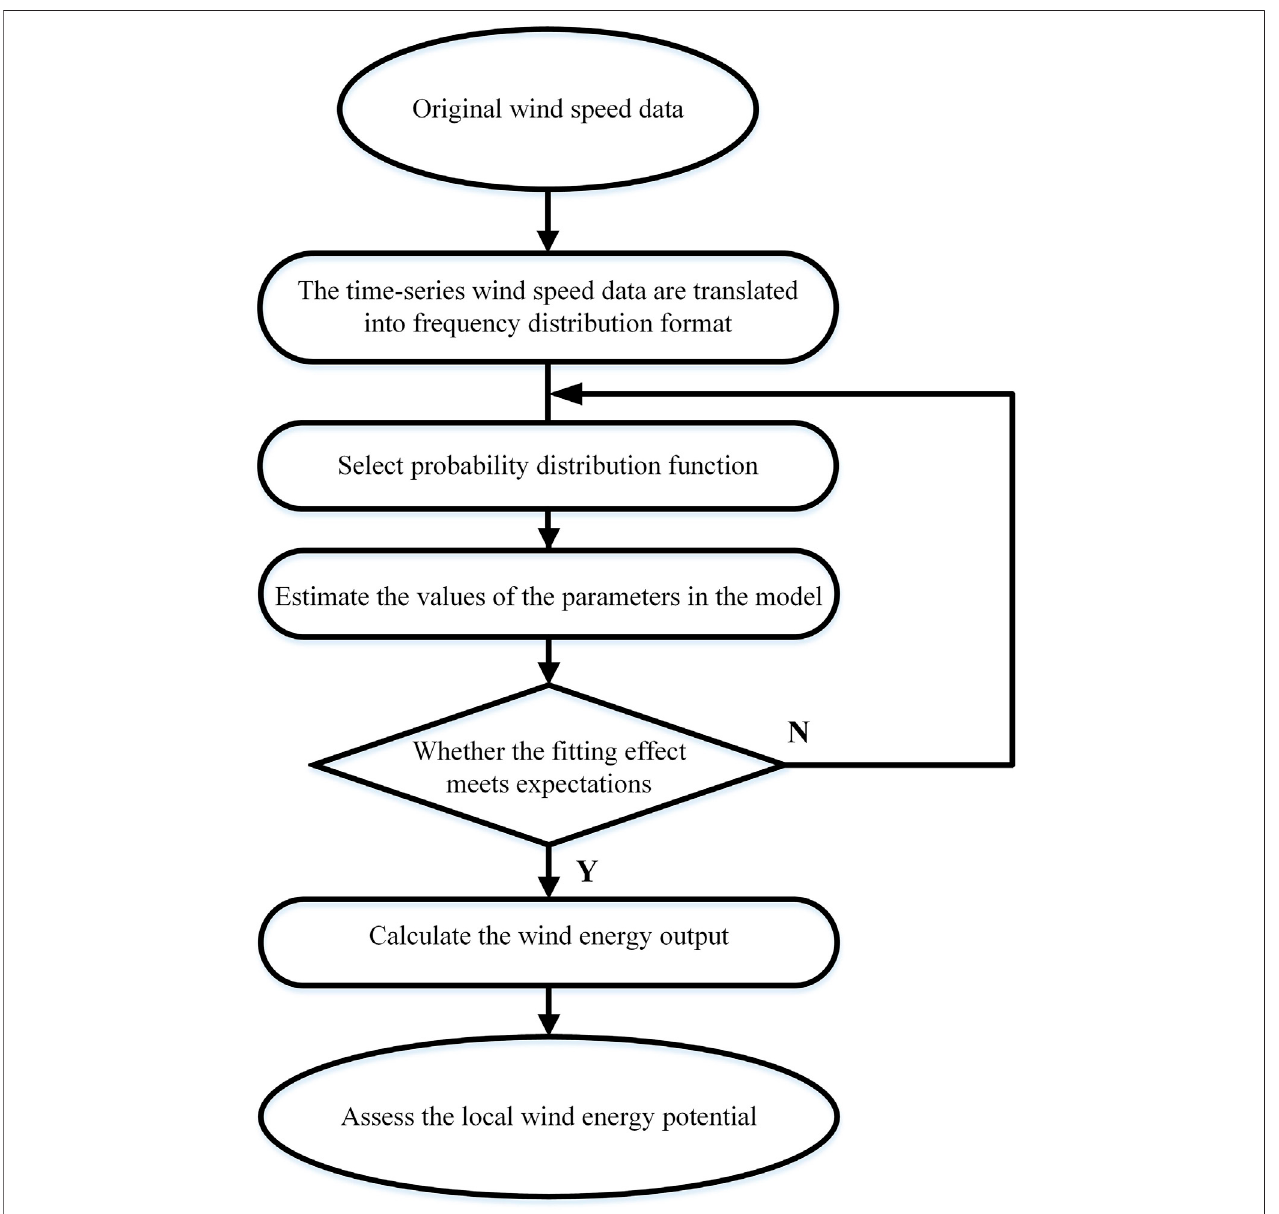
FIGURE 2 | The process of evaluating local wind energy potential based on original wind speed data.